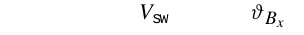
for 2002–2007. x are indicated by P 10 x